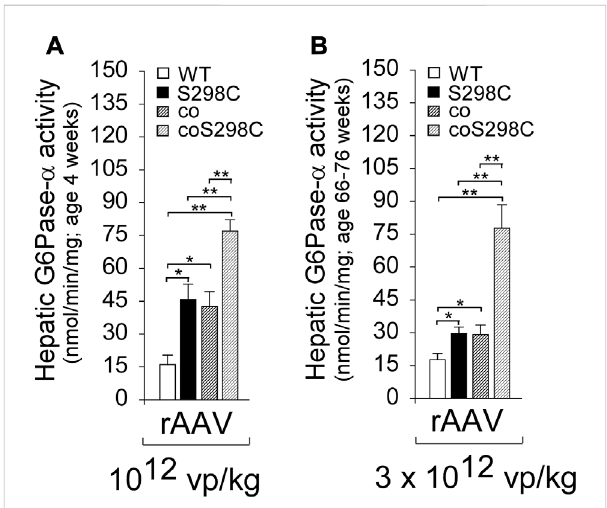
FIGURE 6 The effects of codon optimization and catalytic activity optimization are additive and stable. (A) G6pc _/_ mice were treated at age 2 weeks with 10 12 vp/kg rAAV-G6PC-WT, rAAV-G6PC-S298C, rAAV-coG6PC, or rAAV-coG6PC-S298C (n = 6 per group) and analyzed at age 4 weeks (Zhang et al., 2019). (B) G6pc _/_ mice were treated at age 2 weeks with 3 x10 12 vp/kg rAAV-G6PC-WT, rAAV- G6PC-S298C, rAAV-coG6PC, or rAAV-coG6PC-S298C (n = 6 per group) and analyzed at age 66 – 76 weeks. Hepatic microsomal G6Pase- α activityshowstheadditiveeffectsofthecodonandcatalytic activity